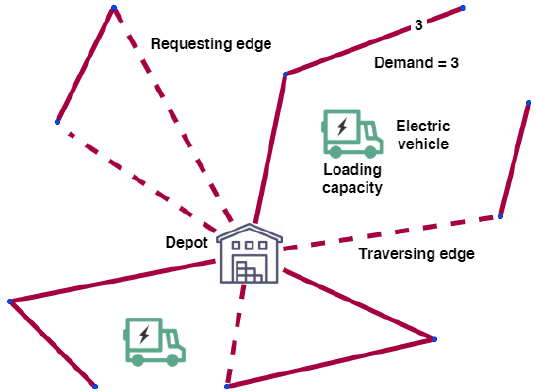
Figure 4. Visual representation of a basic